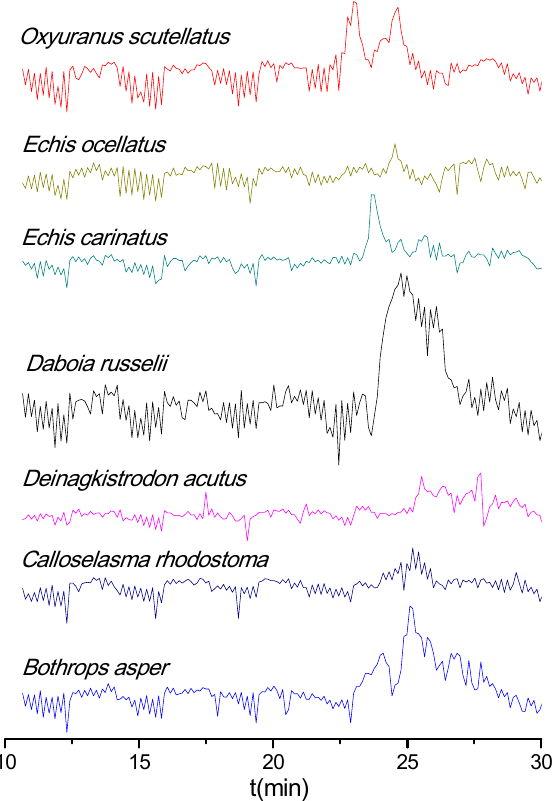
Figure 1. Phospholipase A 2 (PLA 2 ) bioactivity chromatograms of nanofractionated venom toxins. Positive peaks indicate PLA 2 activity.